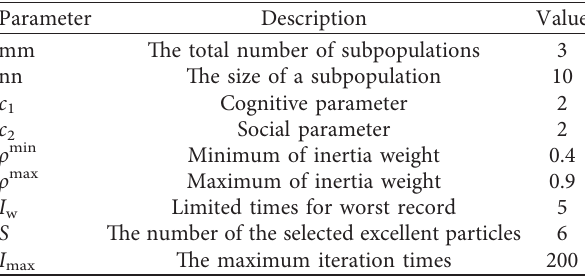
Table 2: Specifications of IMPSCO algorithm.